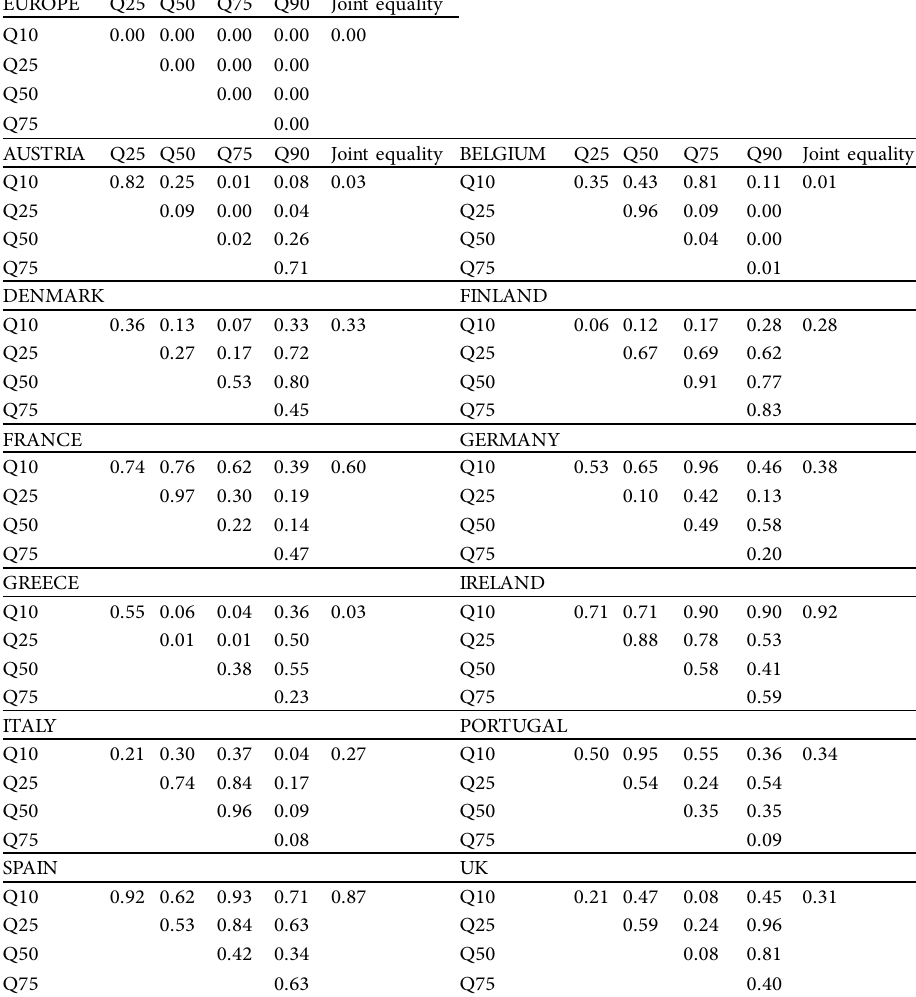
Table 6. Tests for the equality of coefficients at different quantiles (p-values). Overqualification